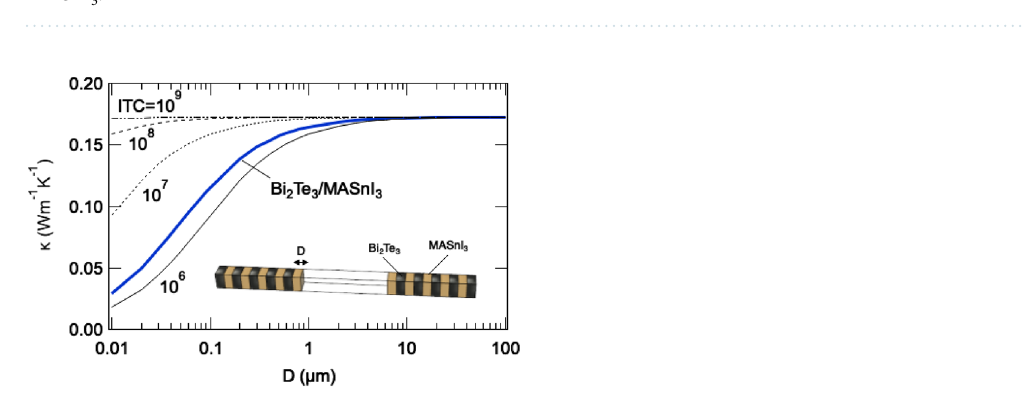
Figure 9. Interfacial thermal conductance of the Bi 2 Te 3 /MASnI 3 interface along the a-axis, b-axis, and c-axis of MASnI 3 .